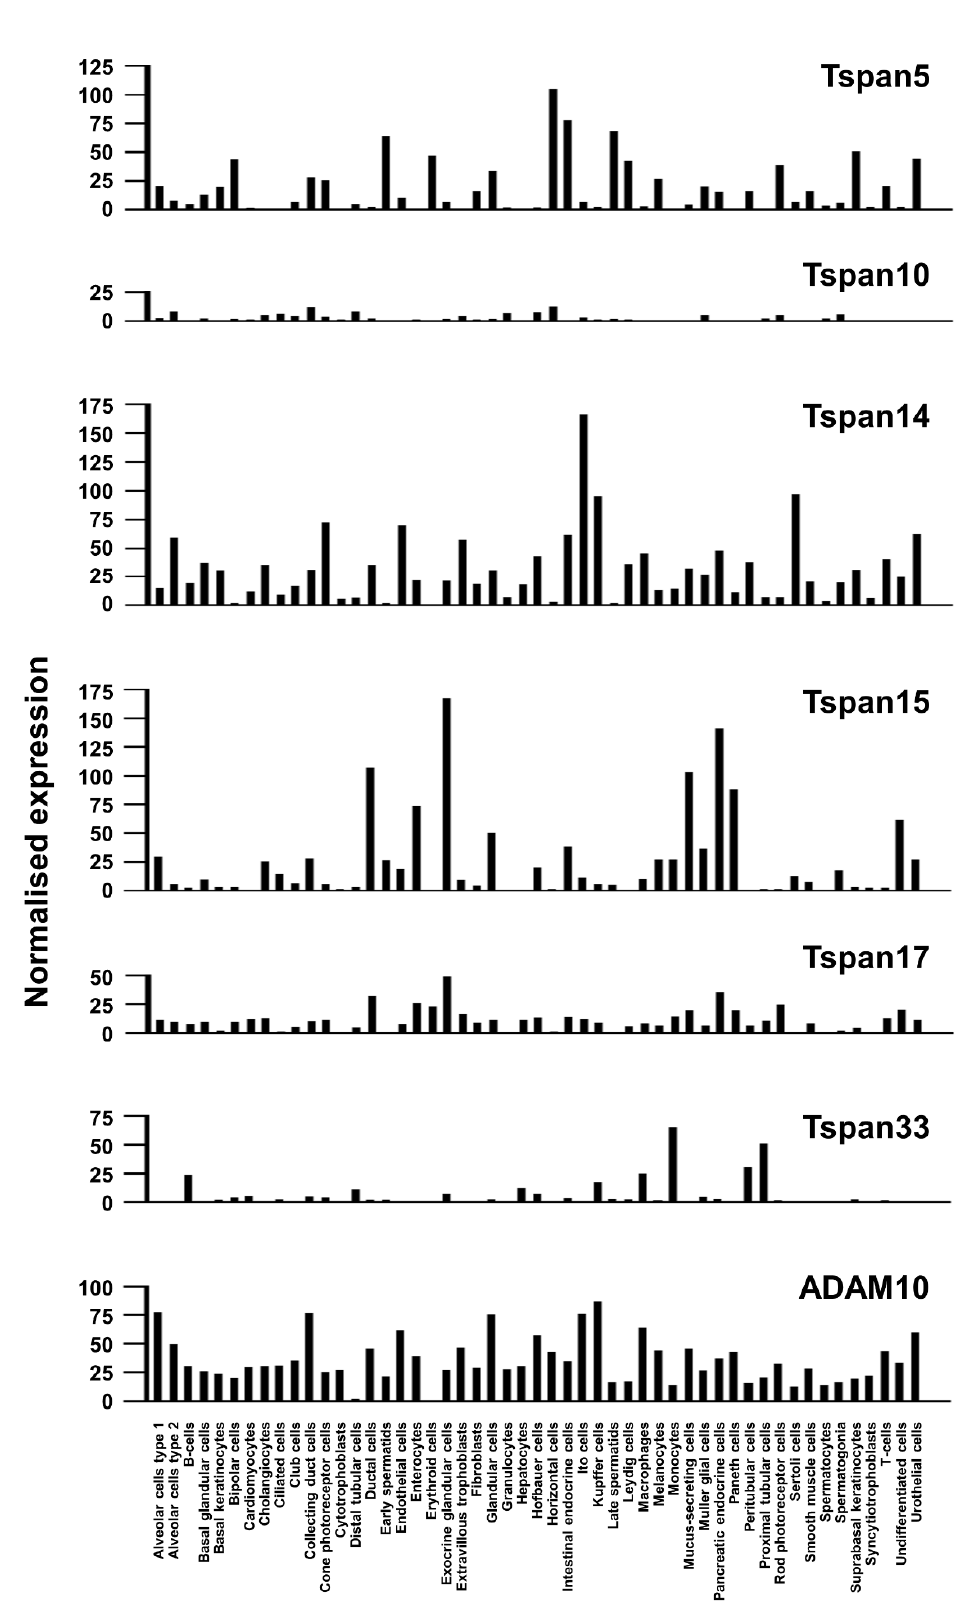
Figure 3. Expression profile of TspanC8s and ADAM10. The data is compiled from single-cell RNA sequencing data from the Human Protein Atlas (www.proteinatlas.org (accessed on 21 May 2021)) [63].